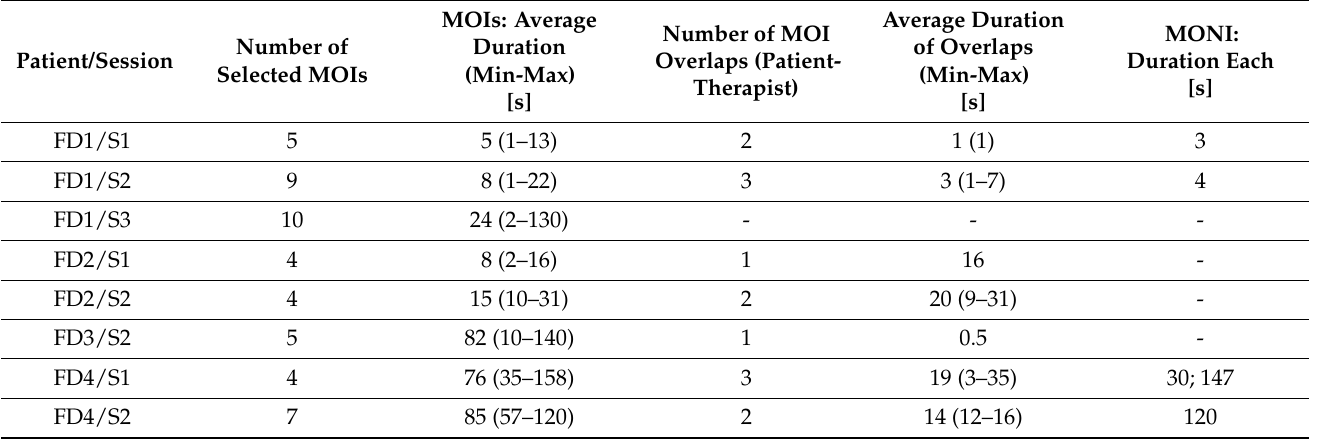
Table 3. Patients’ MOI/MONI selections and